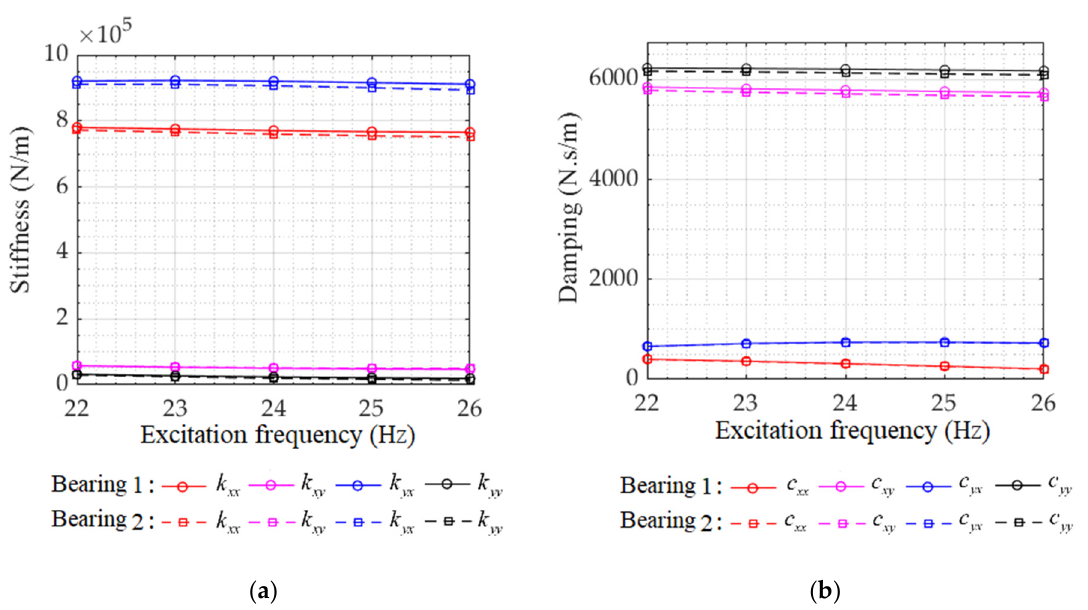
Figure 12. Estimates for the two bearings in Experiment 1. ( a ) Estimated stiffness coefficients of two bearings; ( b ) Estimated damping coefficients of two bearings.